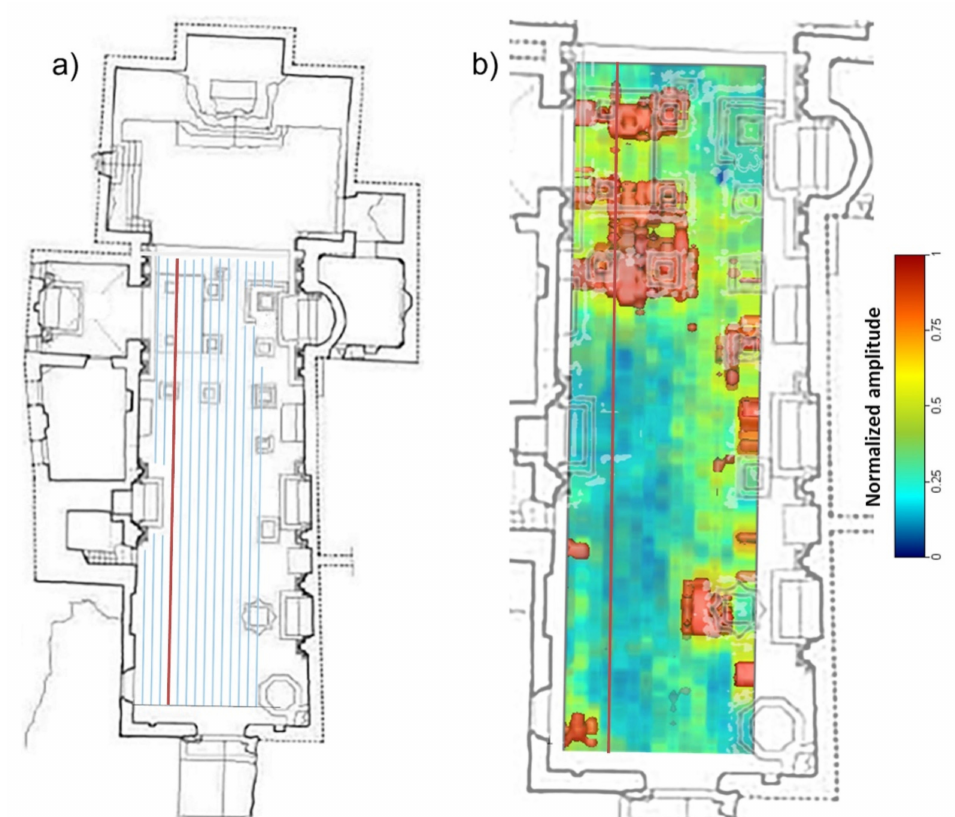
Figure 7. ( a ) Plan of the church; the thin blue lines indicate the path of the GPR profiles; ( b ) detail of the nave plan showing the superimposition of the paved floor with the 3D reflectivity model. The red line indicates the position of the 2D profile shown in Figure 8.